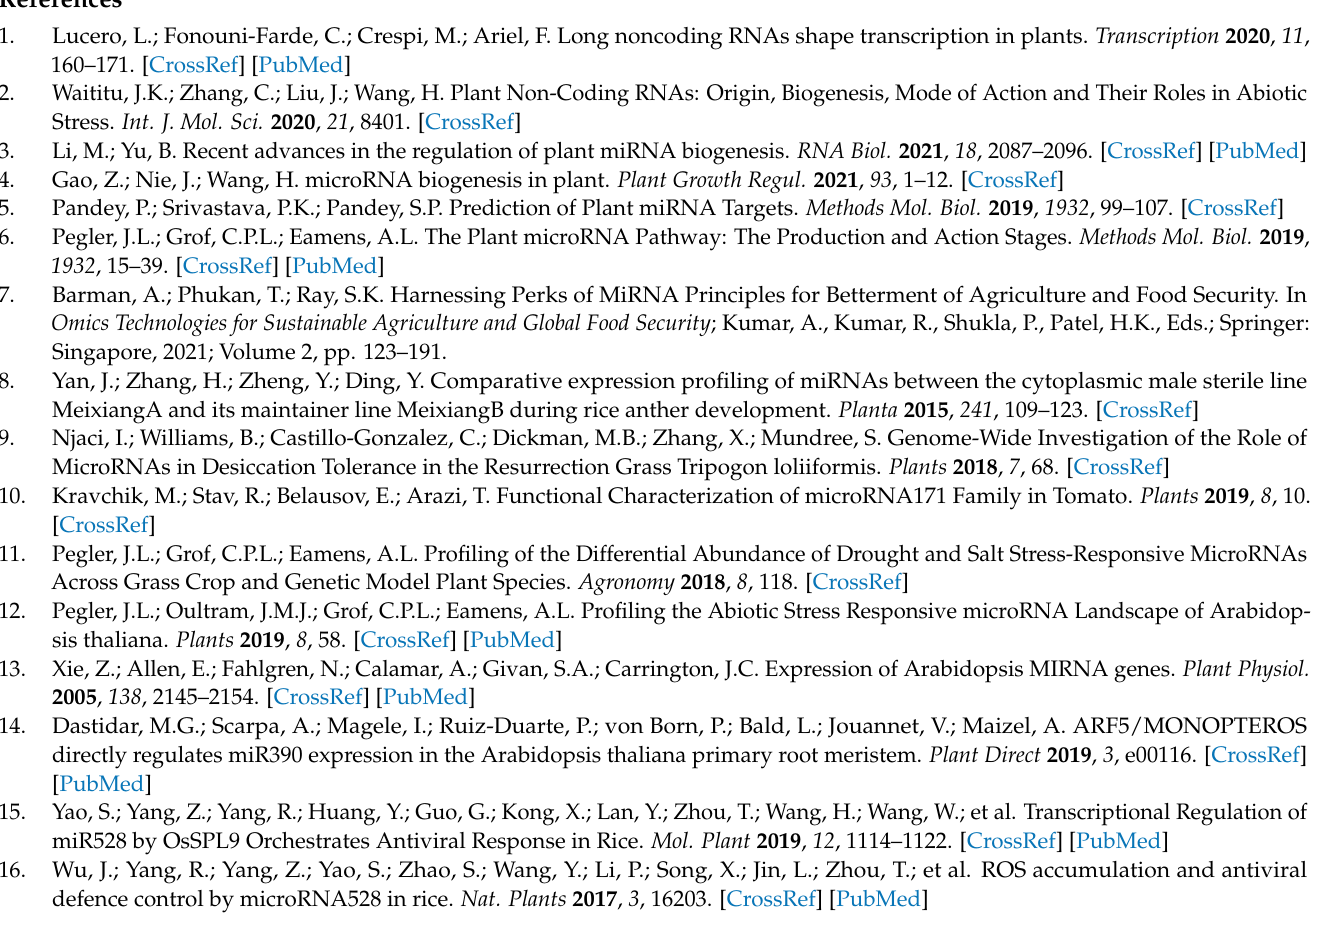
S6. Negative impact of nitrate and auxin treatments on miR528 target accumulation. Figure S7. Zma- MIR528a promoter drives basal reporter expression in maize protoplasts. Figure S8. Protoplasts co-transfection assays. Figure S9. The TATA box, TGA1/4, and AuxRE sites of the Zma- MIR528a promoter are conserved among lines. Table S1. miR528 precursors genomic localization in